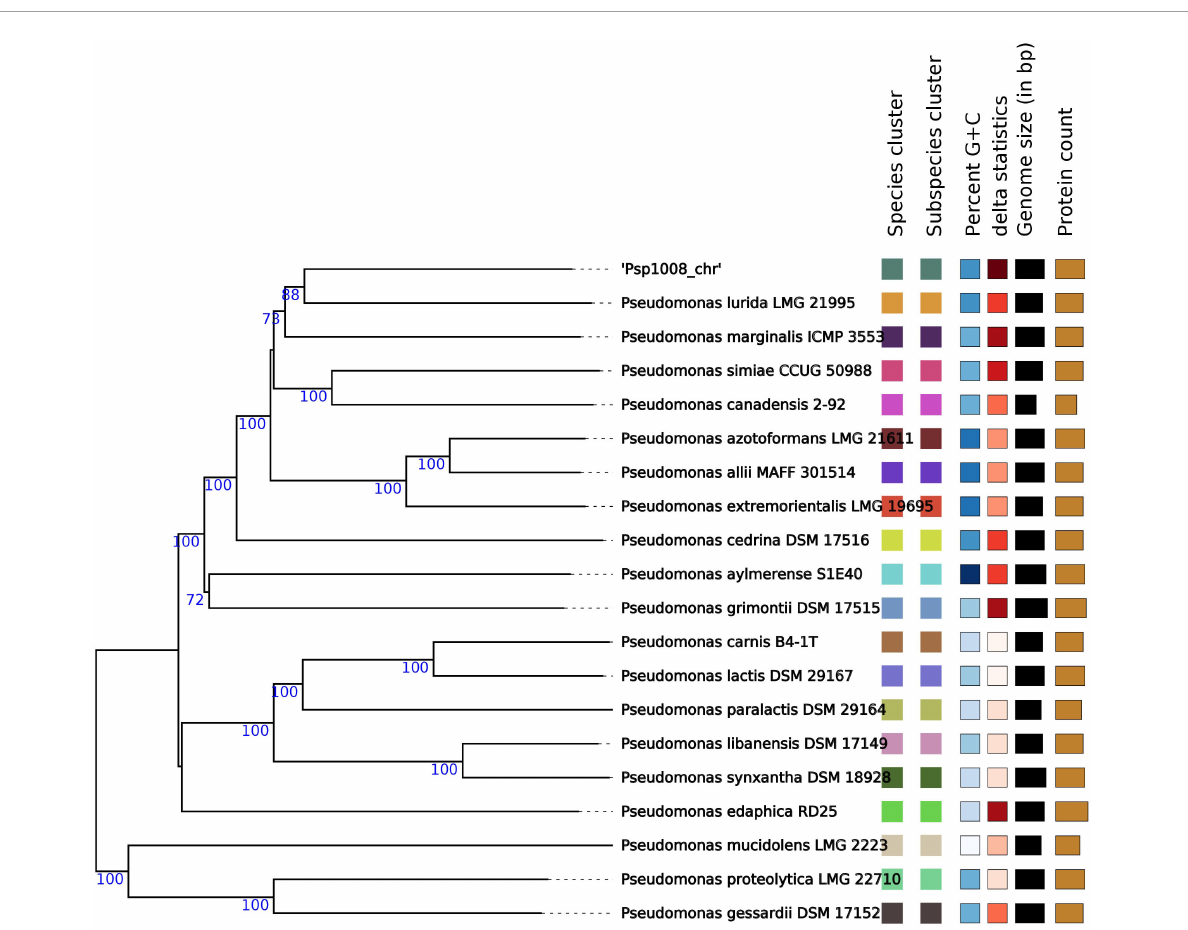
FIGURE4 Genome BLAST Distance Phylogeny (GBDP) tree of Pseudomonas sp. strain 1008. The phylogenetic tree was constructed with the type (Strain) Genome Server (Meier-Kolthoff and Göker, 2019), which produces a GBDP tree by approximating intergenomic relatedness using the MASH algorithm among all type strain genomes in the TYGS database and by extracting and comparing 16S rRNA gene sequences with > 14.990 type strains using BLAST as a proxy to identify the 50 closest type strains to calculate precise distances. The tree itself was constructed using FastME version 2.1.4 to infer a balanced minimum evolution tree with branch support. The tree represents only the Pseudomonas spp. most closely related to strain 1008. Bootstrap support values are shown at the nodes. The leaf label “Species cluster” assigns a different color to denote genomes from different type